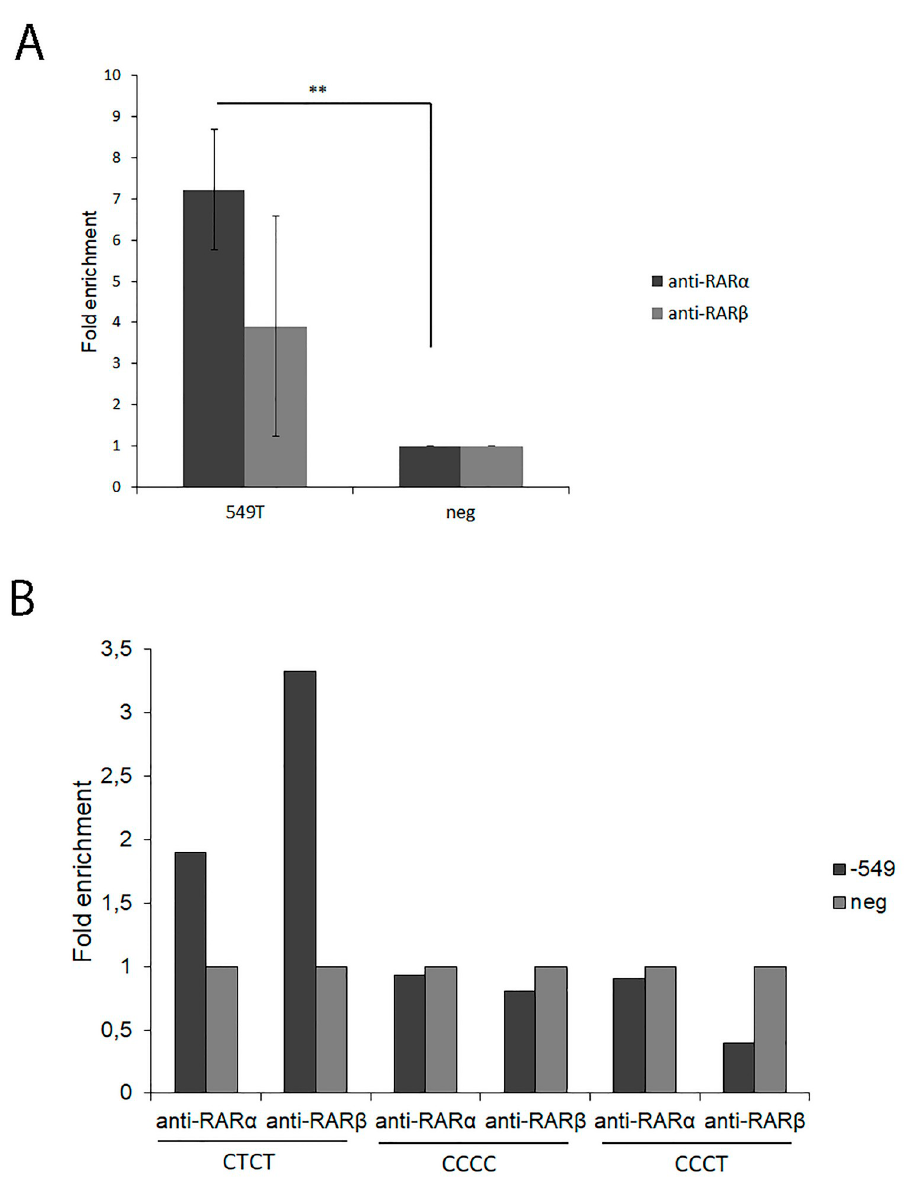
Fig 3. ChIP analysis of RAR isoforms on the PTGDR promoter. A. KU812 cells were exposed to 1 μ M ATRA or DMSO for 24h. ChIP assays were performed with antibodies against RAR α and RAR β . Normal Rabbit IgG was used as the negative control for immunoprecipitation. Immunoprecipitated DNA was amplified by qPCR using primers spanning the polymorphic variant -549T > C in the proximal region of the PTGDR promoter or using the distal PTGDR intron region (negative primers). Results are presented as the fold enrichment of chromatin DNA precipitated by the specific antibody compared with normal rabbit IgG. ATRA data were normalized versus DMSO. Values are means from three independent experiments. �� P < 0.01 for anti-RAR α immunoprecipitated chromatin in the -549T promoter region versus the distal region of PTGDR (negative control), n = 3. B. PBMCs isolated from subject bearing the CTCT, CCCC or TCCC- PTGDR haplotype variants were subject to ChIP assays with anti-RAR α and RAR β antibodies as previously described, n = 1.